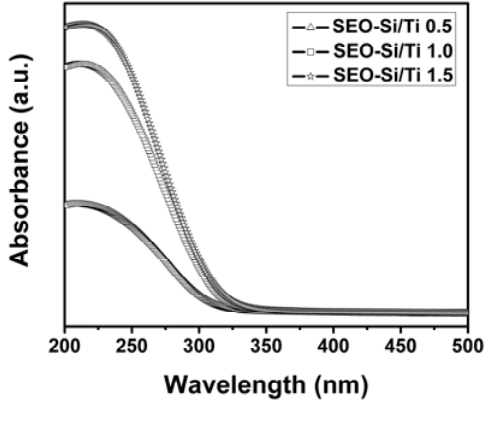
-TiO composite thin films 2 2